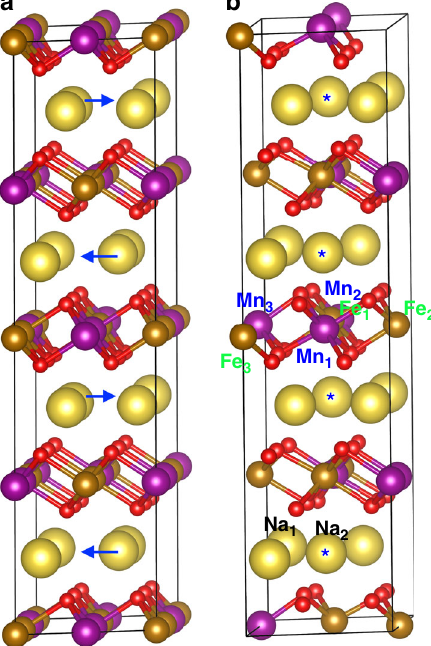
Fig. 6 Atomic con fi gurations of P2-Na 2/3 Fe 1/2 Mn 1/2 O 2 and antisite defect positions. a Before structural relaxation. All Na cations are placed at 2 d sites initially. The blue arrows indicate the moving directions of some Na cations after relaxation. b After structural relaxation. The Na cations with an asterisk (*) are those moving to the new 2b sites. The labeled TM and Na cations are those used to create antisite pairs. The two fi gures show some additional atoms at simulation box boundaries for visualization purpose (based on periodic boundary conditions). Large yellow spheres: Na; medium brown spheres: Fe; medium purple spheres: Mn; small red spheres: O.